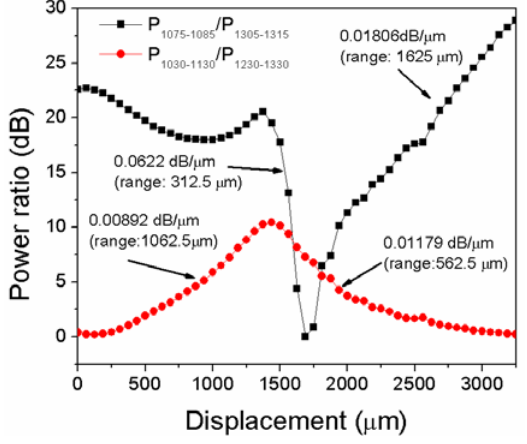
Figure 7. Ratio between integrated spectral powers as a function of